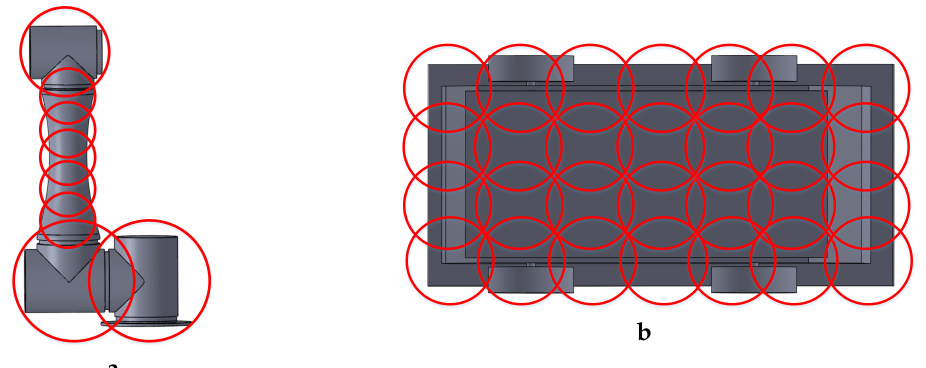
Figure 5. Multi-element approximation of the component. ( a ) The approximation of the component in the manipulator subsystem; ( b ) The approximation of the mobile